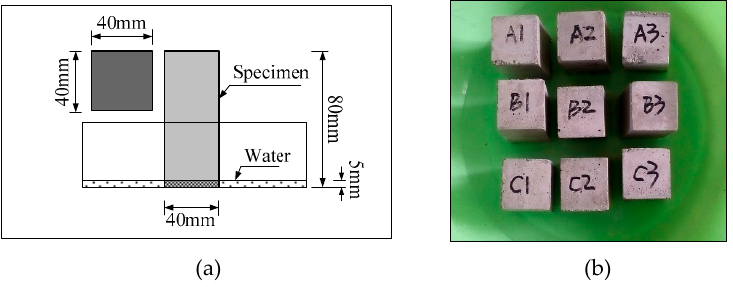
Figure 3. Capillary water absorption test schematic diagram ( a ) and measured diagram ( b ).